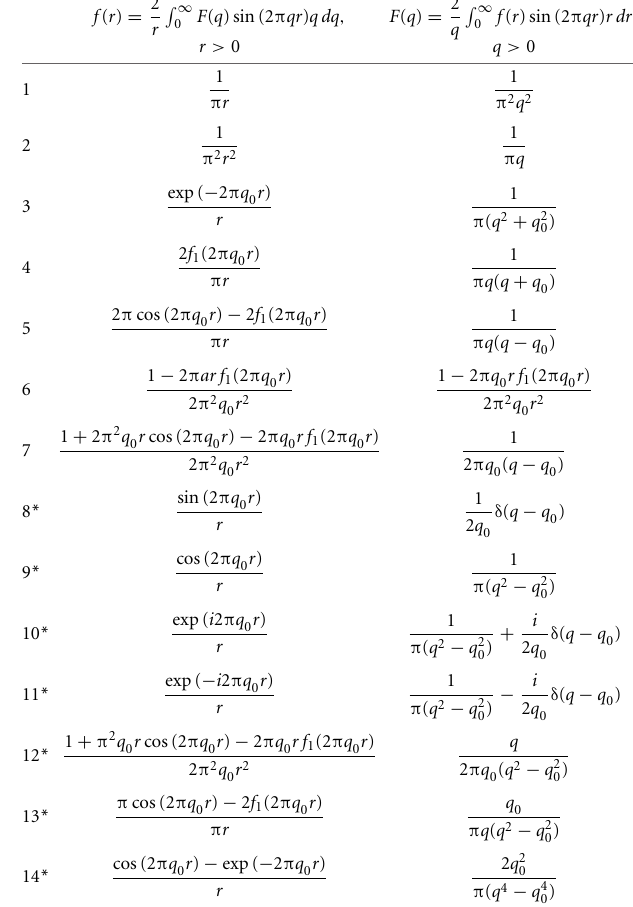
Table 1 | Spherically-symmetric Fourier transform pairs in